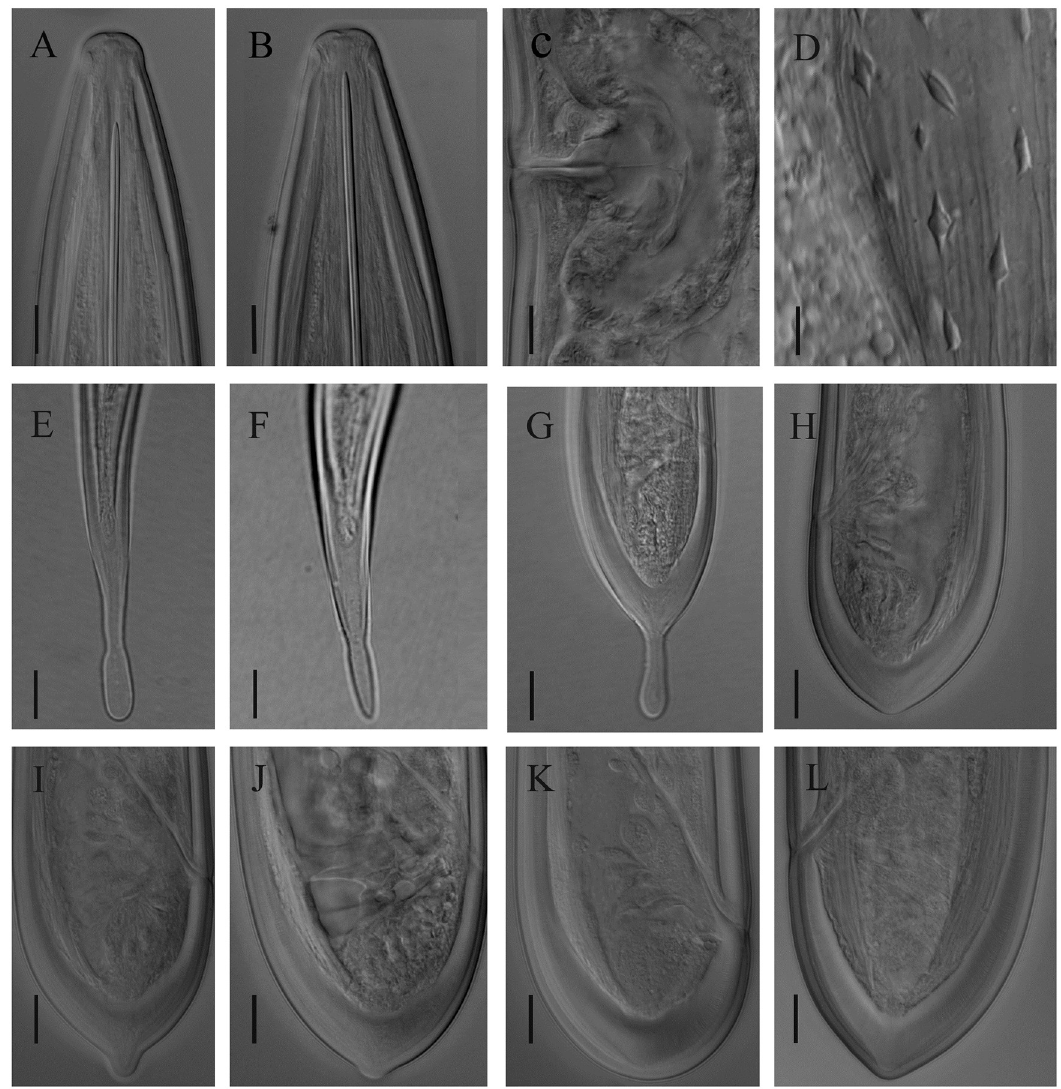
Fig 2. Light micrographs of Xiphinema afratakhtehnsis sp. nov., female paratypes and and J1-J4 stages. A&B) Anterior region. C) Vulval region. D) Spines in uterus of fresh females. E-H) Tail of juvenile developmental stages (J1-J4) respectively. I&J) Variation in J4 tail. K&L) Female tail shape (K: the common shape, L: tail end with bulge observed in few females). Scale bars = 10 μ